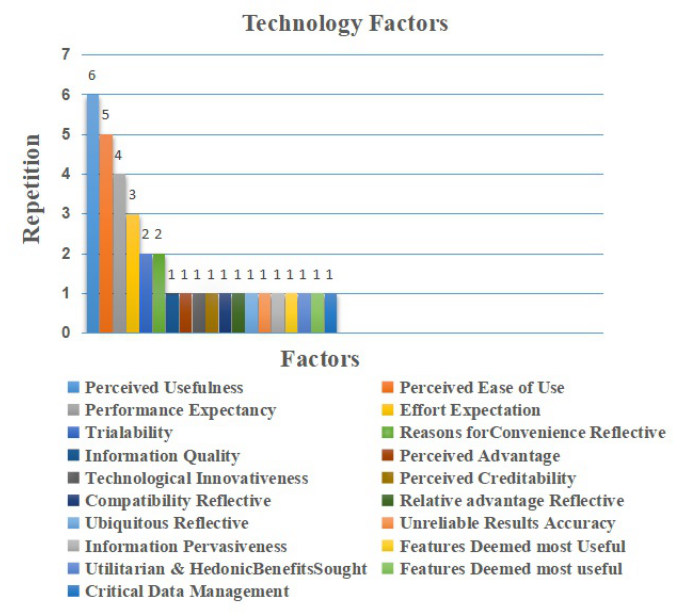
Figure 8. Technology Factors.